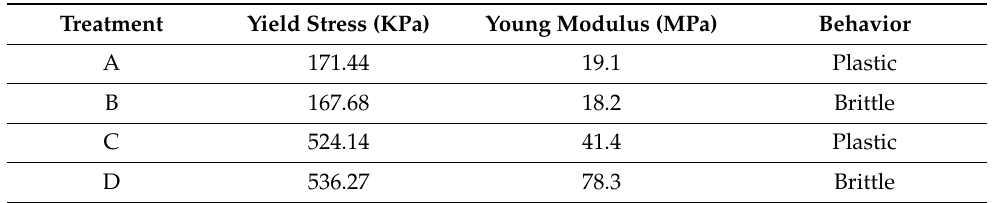
Table 2. Material Characteristics of Tested Mixtures.